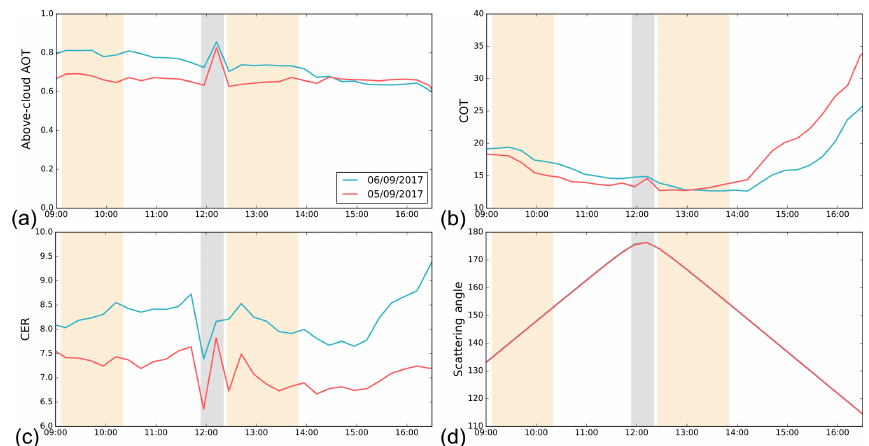
Figure 13. Time series (UTC) of the above-cloud AOT (a) , COT (b) , CER (c) and scattering angle (d) averaged between 20 and 10 ◦ S and 5 and 15 ◦ E for 5 and 6 September 2017. The grey area represents scattering angles larger than 175 ◦ and the orange areas show the typical overpass times of MODIS Aqua and Terra over the region.